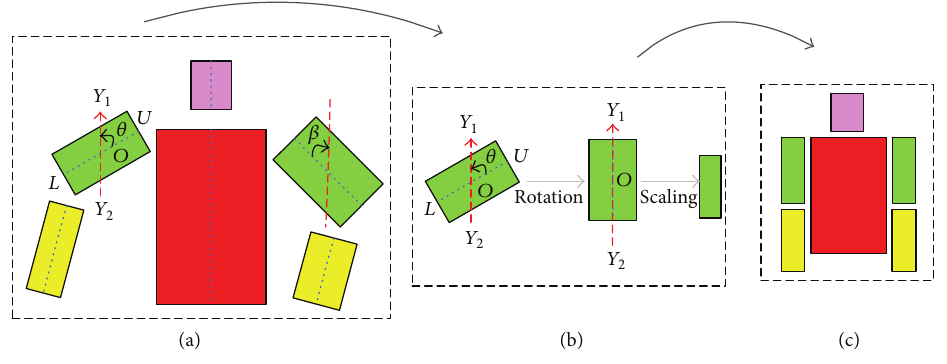
Figure 5: An illustration of the body parts normalization